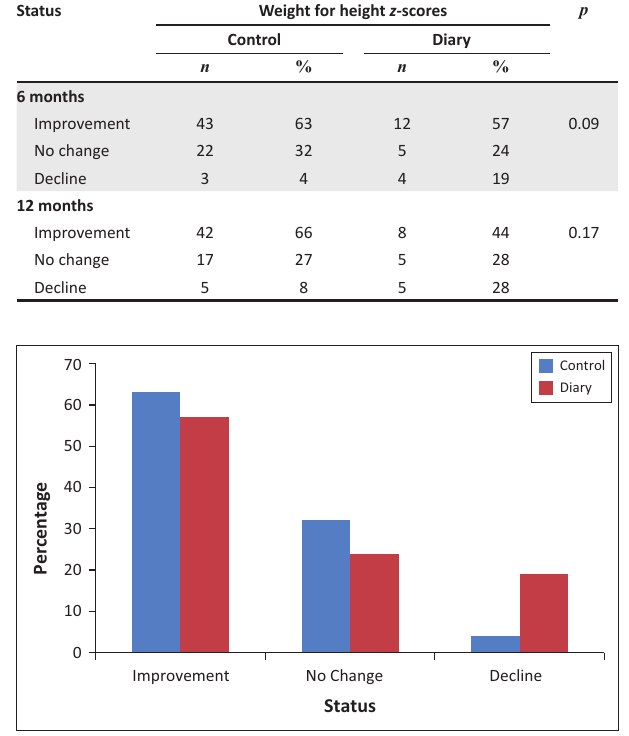
FIGURE 5: Weight for height z -score response at 6 months for both groups.